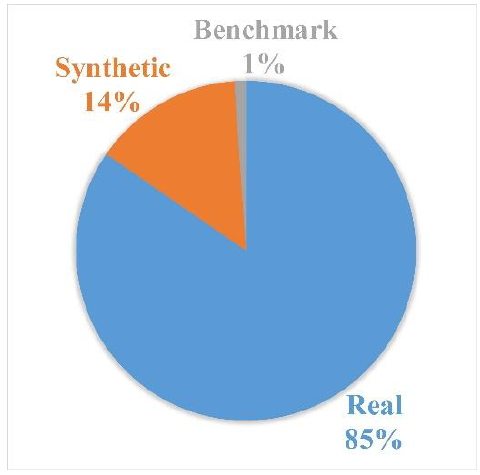
Figure 10. Data type breakdown.